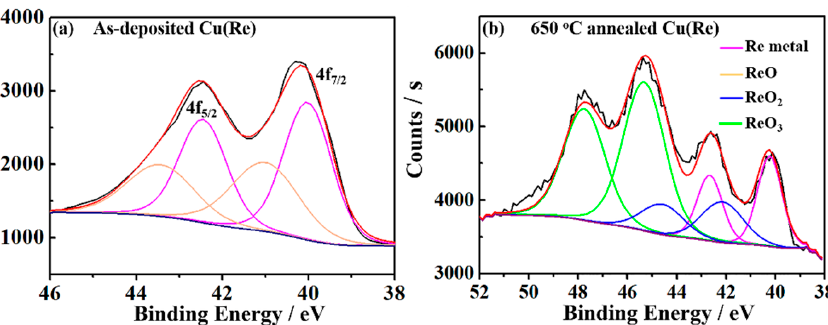
Figure 5. XPS spectra of Re 4f at the Cu(Re)/SiO 2 interface of the ( a ) as-deposited film and ( b ) Cu(Re) film annealed at 650 °C.